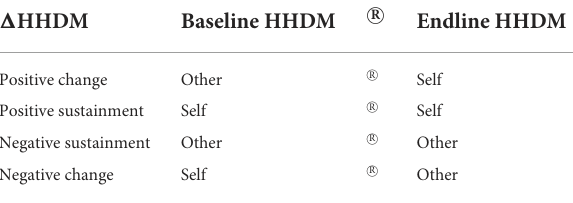
TABLE 3 Variables depicting the change in household decision-making from baseline to endline. Categories of change in household